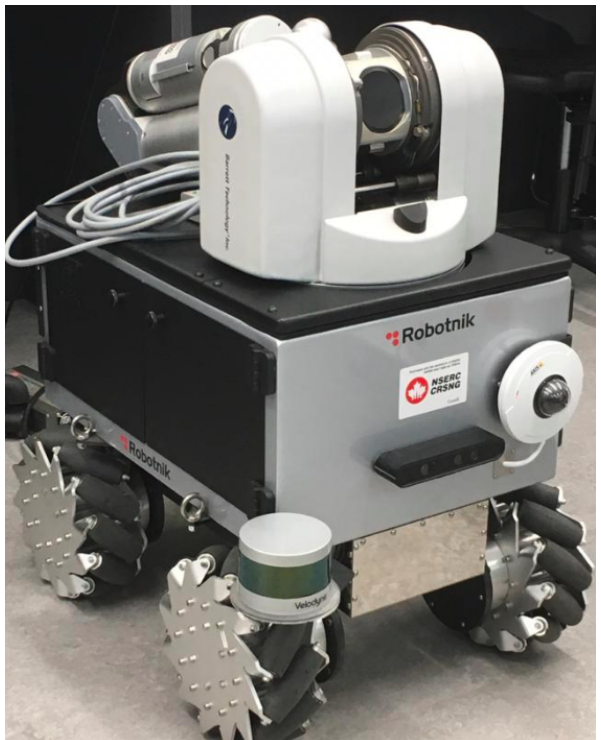
Figure 5. The omni-directional mobile robot used to validate the monocular VO algorithm with the proposed